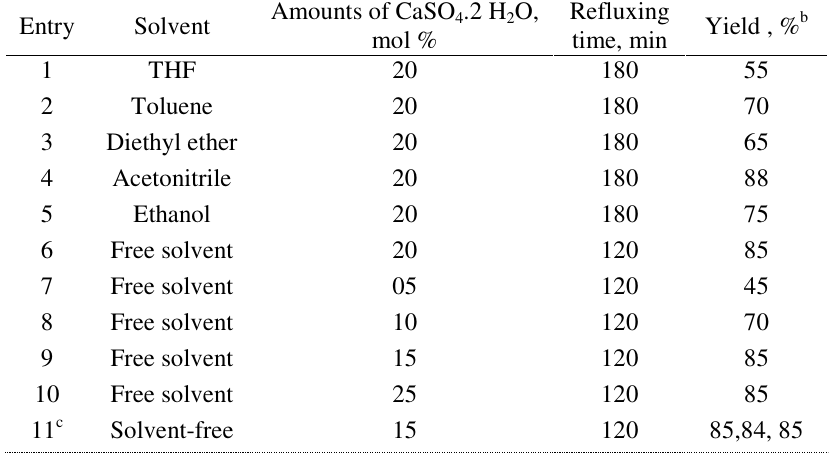
Table 1. Effect of catalysts under different reaction conditions for condensation of benzaldehyde, ethyl acetoacetate and urea a